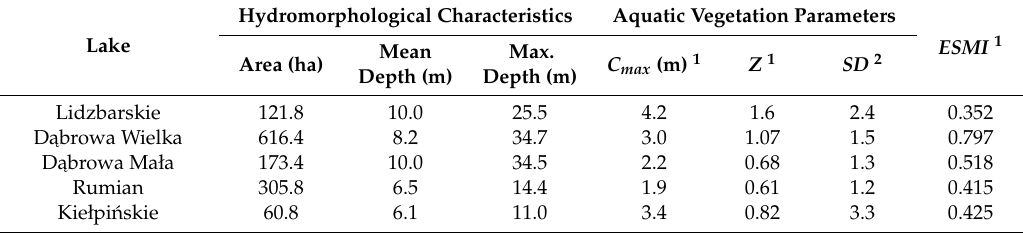
Table 2. Hydromorphological characteristics and aquatic vegetation parameters ( Z —colonization index, C max —maximum vegetation depth; SD —Secchi disc) in the growing season of 2009 of lakes, which were used to develop the macrophyte-based method for a retrospective evaluation of the ecological status of lakes.